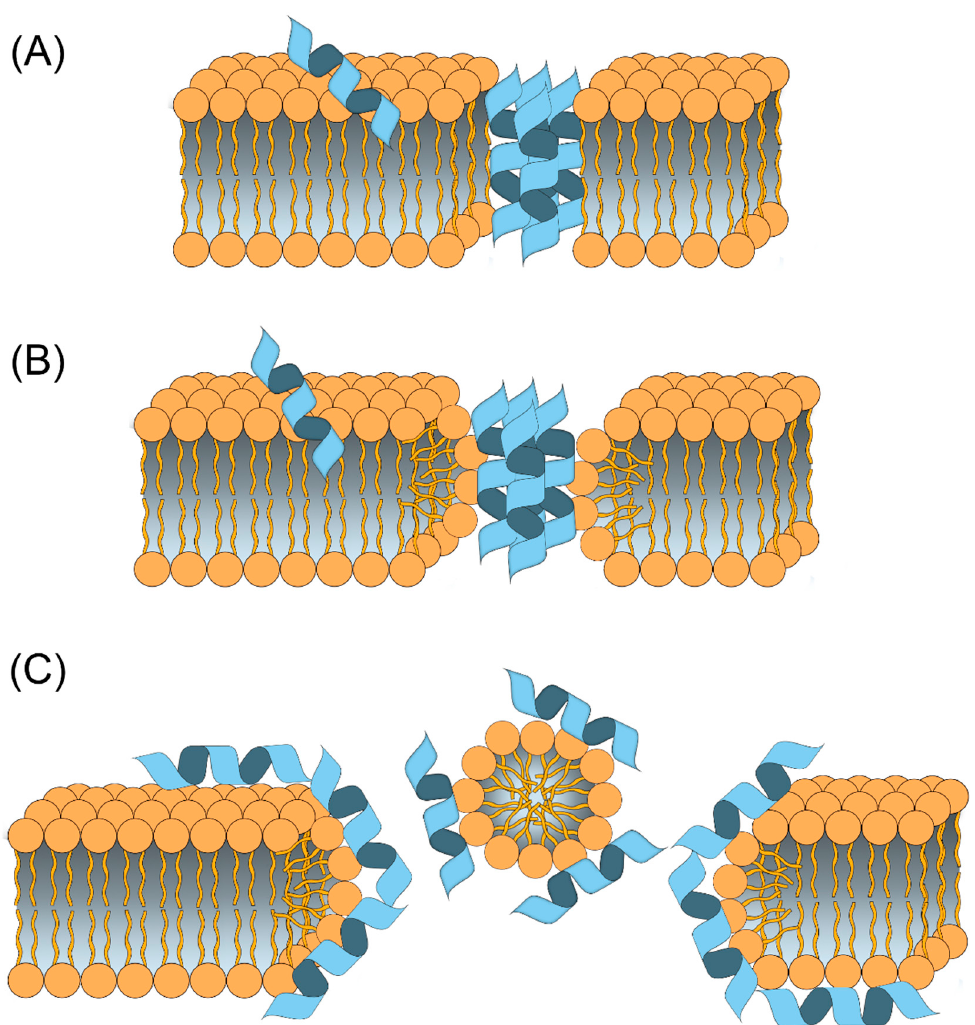
Figure 3. Most widely accepted models for extracellular AMPs mechanisms of action. ( A ) Barrel- stave model: AMPs aggregate as multimers and arrange parallel to the phospholipids of the cell membrane to form a hydrophilic transmembrane channel. ( B ) Toroidal pore model: AMPs accumulate vertically within the membrane causing the lipid moieties to fold inward to form a circular pore. ( C ) Carpet model: AMPs interact with the surface and act as a “detergent” isolating different portions of the membrane.